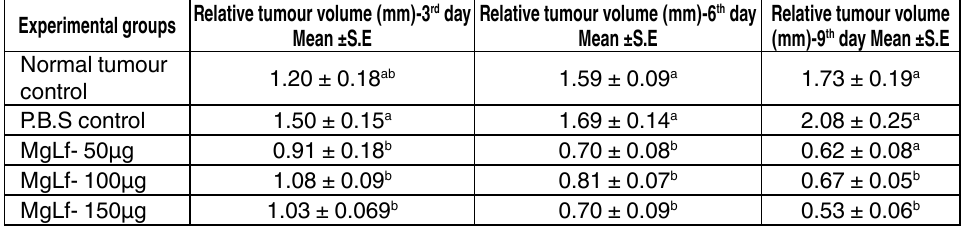
Table 2. Tumour weight: body weight ratio in different groups of tumour induced mice Experimental